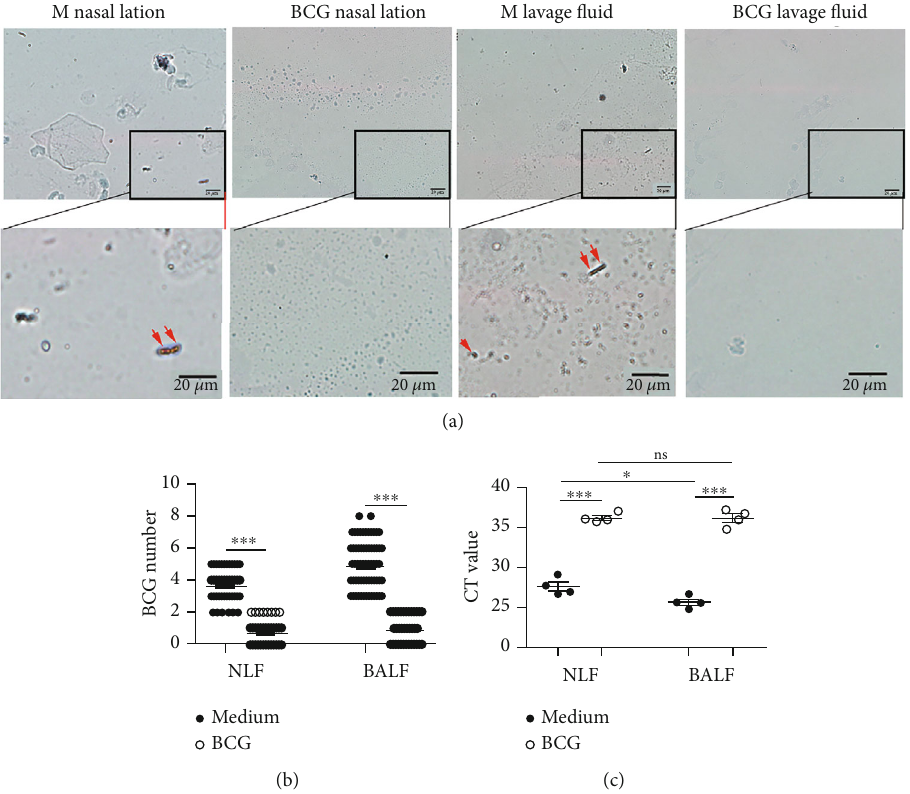
Figure 6: Antigen-speci fi c tissue-resident memory T cells generated by BCG vaccination protected against the infection of live BCG. (a) NLF and BALF from mice after intranasal vaccination with or without BCG were infected intranasally with live BCG and stained with Gram (scale bar =100 micros; magni fi cation, 40x and 100x). (b) ( n = 30 ) The statistical results of the numbers of BCG in NLF and BALF were counted in the slice of Gram staining vision; (c) ( n = 4 ) The levels of BCG mRNA in nasal lavage fl uid and lavage fl uid were determined by qPCR as mean ± SEM . Statistical signi fi cance was determined with two-way ANOVA for multiple comparisons. ∗ P < 0 : 05 and ∗∗∗ P < 0 : 001 ; ns: no signi fi